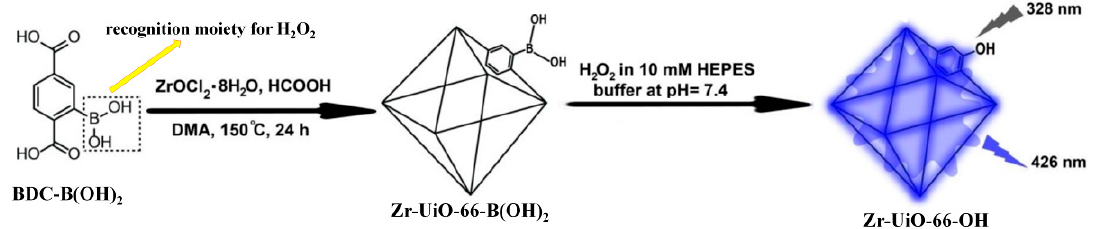
Figure 18. Schematic illustration of the sysnthesis of Zr-UiO-66-B(OH) 2 and the sensing process for H 2 O 2 . Reproduced with permission from [126]. Copyright American Chemical Society, 2018.